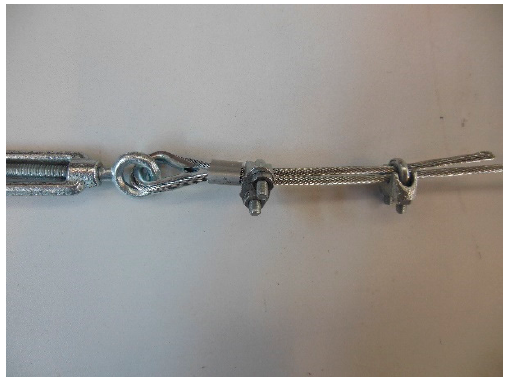
Figure 30. Specimen 5: Flemish eye closed by 1 ferrule and 2 clips, in succession.